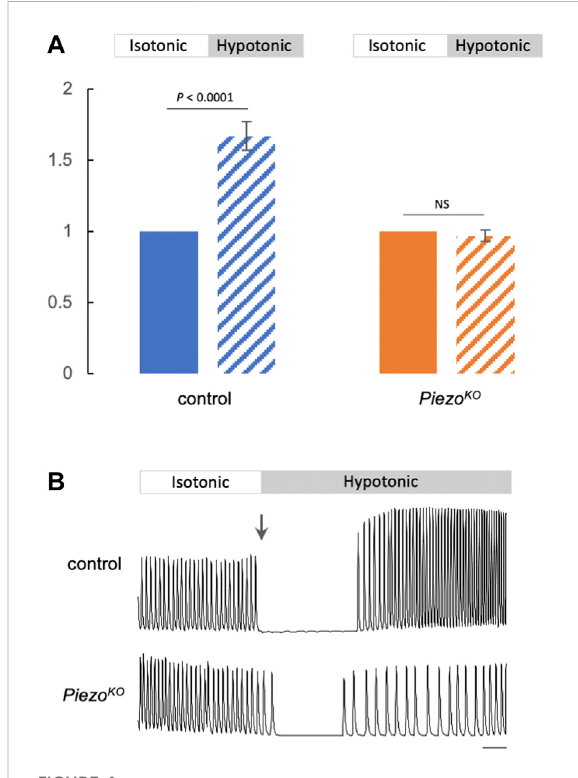
FIGURE 4 Elevated Ca 2+ transients in response to hypotonic stretch require Piezo. (A) Summary data comparing Ca 2+ transient amplitude in response to hypotonic stretch in control (blue) or Piezo KO (orange) cardiomyocytes (block colour = isotonic, stippling = hypotonic). Approximately 20 Ca 2+ transients were measured in isotonic media to calculate mean amplitude per cardiomyocyte. The amplitudes of fi rst 10 transients in hypotonic media were averaged. The resulting value was normalised to the isotonic value to allow comparison between genotypes. n = 18 (control) and 19 ( Piezo KO ) individual cardiomyocytes from independent heart preparations. (B) Representative Ca 2+ traces from control (upper) and Piezo KO (lower) cardiomyocytes in isotonic/hypotonic solution (arrow marks the change from isotonic to hypotonic solution). Time is on x -axis, fl uorescence (arbitrary units) on y -axis, scale bar = 1 s. p values, unpaired t-test. NS = not signi fi